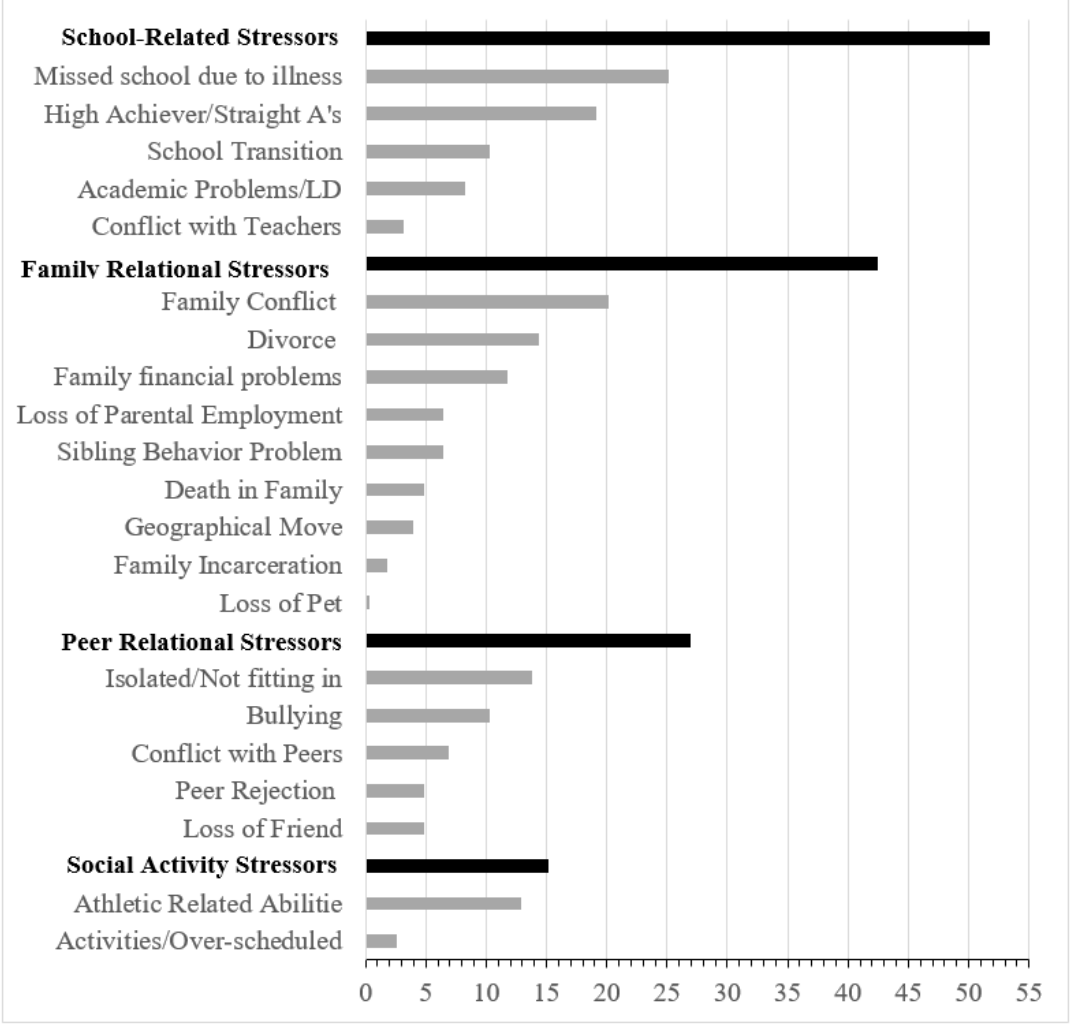
Figure 1. Percentage of participants who reported each stressor. Stressor categories are in bolded rows and include the individual stressors listed below them. Note . Items are not mutually exclusive—participant can report more than one stressor.